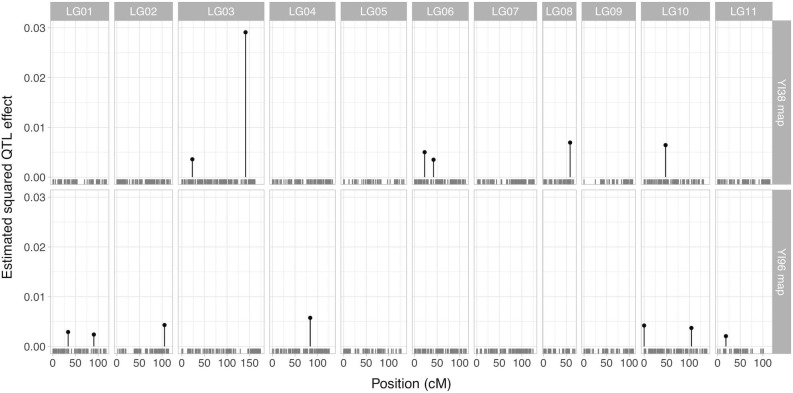
Effect and location of significant QTLs for drought sensitivity at the Chiba site.Panel columns represent linkage groups. Panel rows represent two types of linkage maps based on the marker types (upper: YI96 map; lower: YI38 map). Short vertical lines at the bottom of each panel represent marker positions.